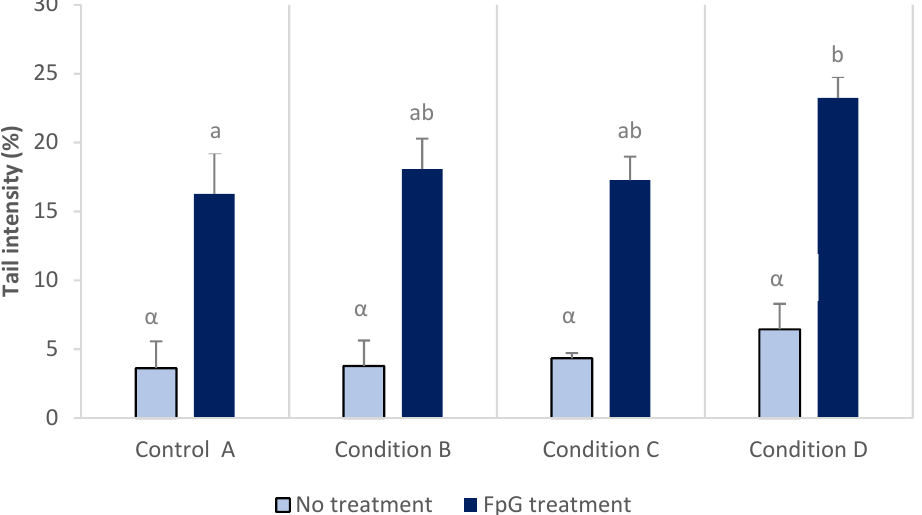
Figure 2. DNA damage in blood cells from rainbow trout larvae after exposure to a mixture of three pesticides (copper, glyphosate and chlorpyrifos), with- and without treatment with the Fpg enzyme. Different letters at the top of the bars indicate significant differences between conditions. Absence of letters indicates no significant differences (Mean ± SD, n = 3, ANOVA, p < 0.05).